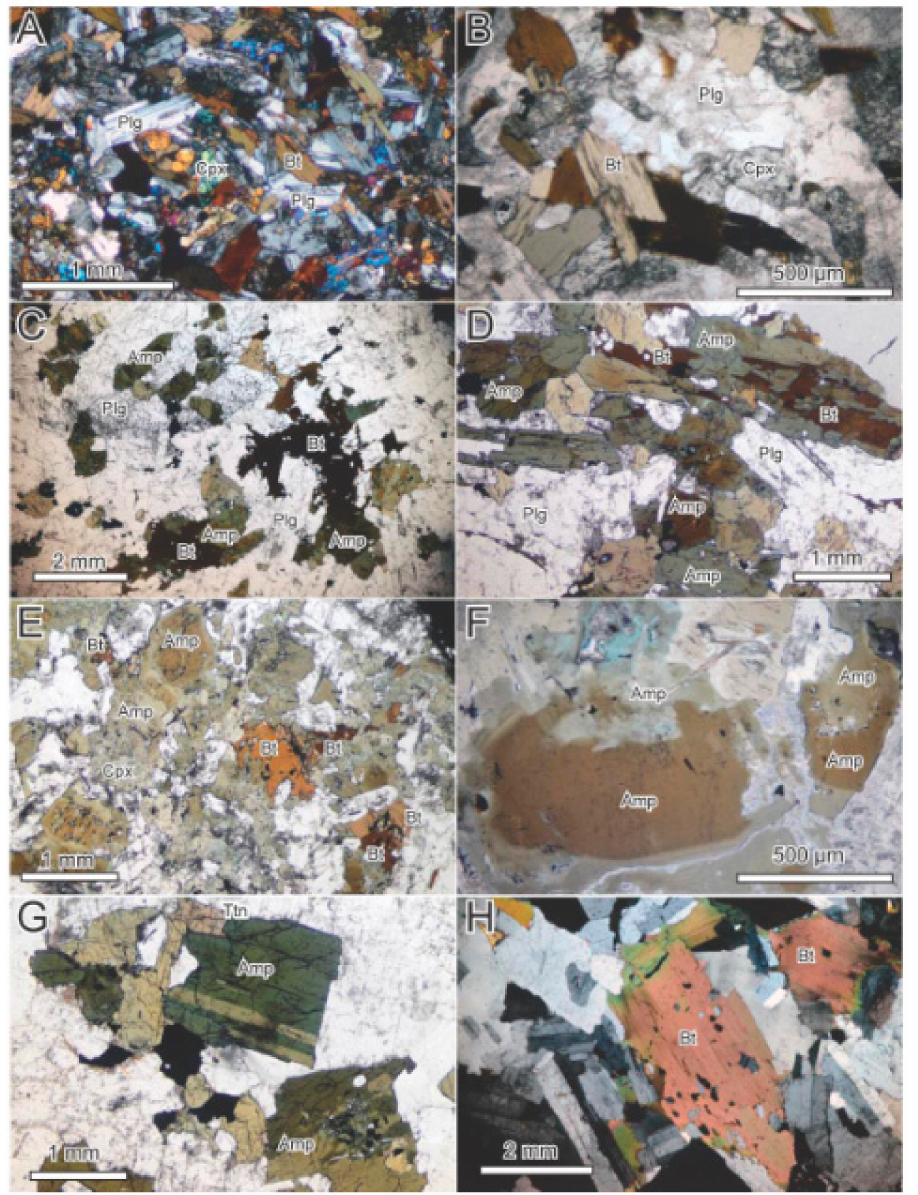
Figure 2. Representative microphotographs of the Valencia del Ventoso main pluton. ( A ) Hypid- iomorphic fine-grained alkaline dolerite VAAW-20 from the inner facies xl; ( B ) detail of the dolerite VAAW-20 showing an intergranular aggregate of biotite, clinopyroxene, and plagioclase, ppl; ( C ) hypidiomorphic medium-grained intergranular texture in diorite VAAW-37 from the intermediate facies, ppl; ( D ) detail of the relationship between amphibole and biotite in diorite VAAW-37, the latter is included in green amphibole and shows evidence of resorption; note also zoned amphibole with anhedral brown core and green overgrowth, also evidencing resorption, ppl; ( E ) medium-grained quartz diorite VAAW-35 from the border facies; note zoned amphibole with anhedral, resorbed, brown core and green overgrowth and anhedral biotite inclusions resorbed by the green amphibole, ppl; ( F ) zoned amphibole grain with resorbed brown core and green overgrowth in quartz diorite VAAW-35, ppl; ( G ) medium-grained monzogranite VAAW-38 from the border facies with green amphibole, ppl; ( H ) detail of biotite in monzogranite VAAW-38, xp. Abbreviations: Amp: amphibole; Bt: biotite; Cpx: clinopyroxene; Plg: plagioclase; Qtz: quartz; Ttn: titanite (xp- and ppl-crossed polars and plane-polarized light,